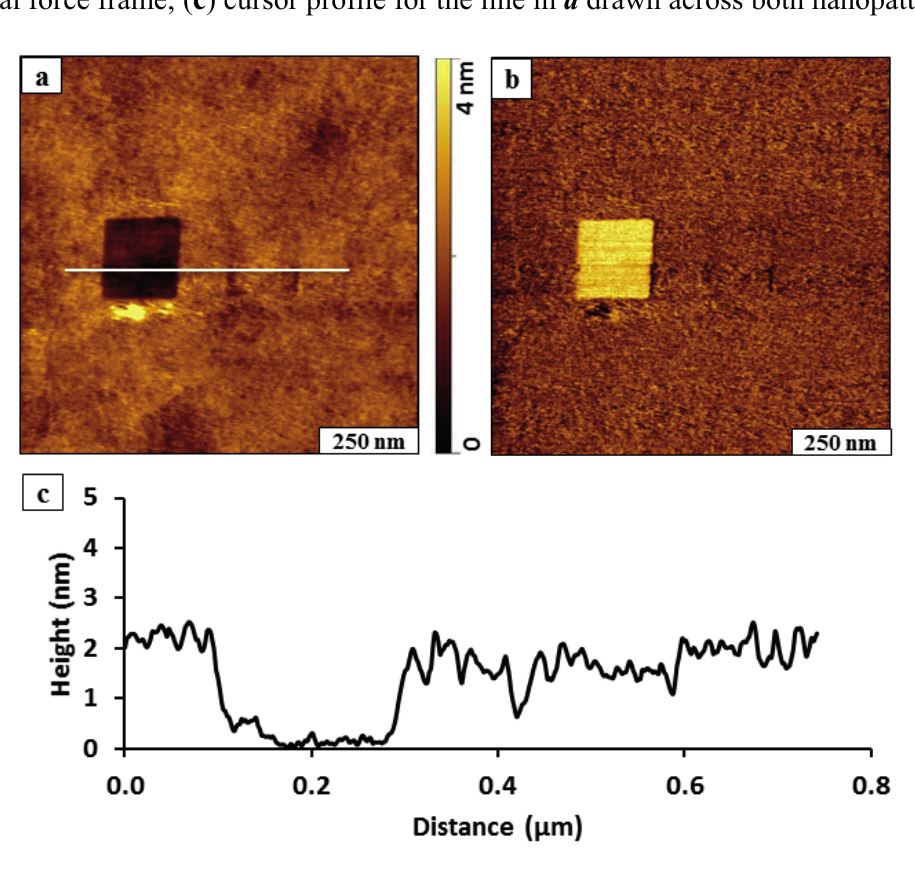
Figure 4. Fabrication of a nanoshaved square and nanografted pattern of BMPHA side-by-side within a monolayer film of BMPHA. ( a ) Contact-mode topography image acquired in ethanol; ( b ) lateral force frame; ( c ) cursor profile for the line in a drawn across both